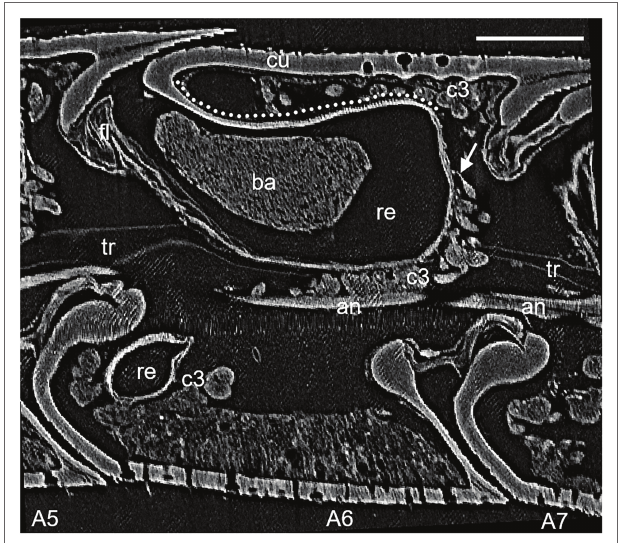
FIGURE 1 | Lateral view of micro-CT ( μ CT) data of antennomere A6 of a female Philanthus ventilabris ; an, antennal nerve; ba, bacteria; c3, class 3 gland cells; cu, outer cuticle; fl, flap mechanism; re, reservoir; tr, tracheole; arrow – conducting canal; and dotted line – reinforced cuticle. Scale bar 100 μ